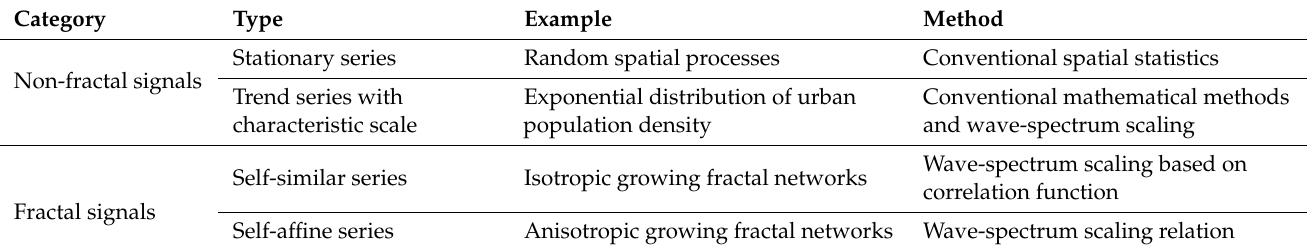
Table 4. Different types of spatial signals and corresponding analytical